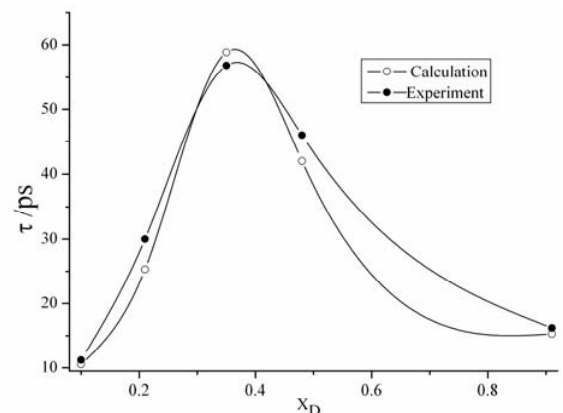
Figure 3. Mole fraction dependence of the relaxation time τ of DMSO-water mixtures at 298 K